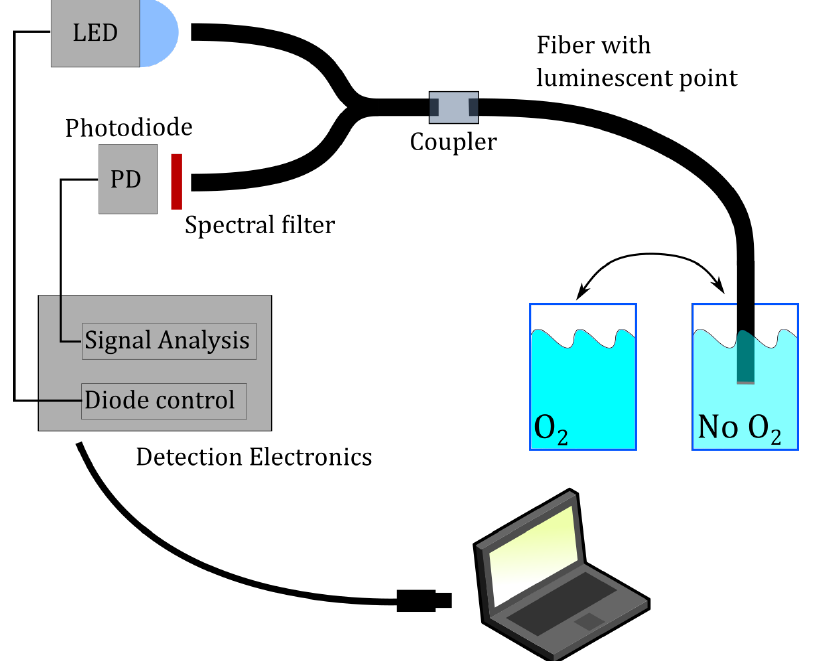
Figure 8. The setup used for oxygen step response measurements. The POF sensor is moved between low-O 2 and high-O 2 concentrations and allowed to equilibrate afterwards. The LED is modulated by the electronics system, which can be controlled from a computer. The signal analysis is implemented as a lock-in amplifier (LIA) and extracts an amplitude and phase from the photoluminescence signal. The phase is measured in comparison with the signal driving the LED.